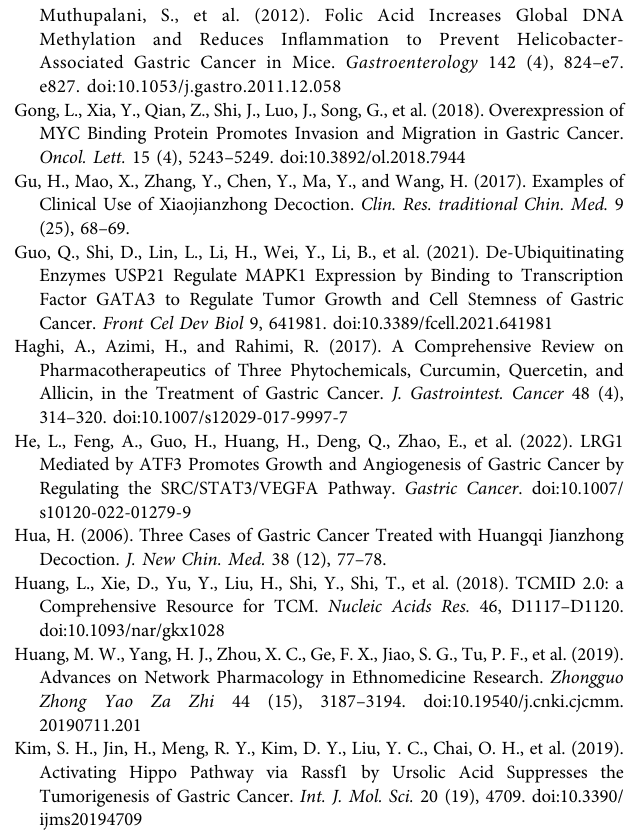
Supplementary Figure S1 | HPLC chromatograms of the standard (Top) and HJT (Bottom). The peaks for the standards, from left to right, represent berberine, formononetin, gingerol, ursolic acid, cinnamaldehyde, and anethole. Supplementary Table S1 | The primer sequences used in this present